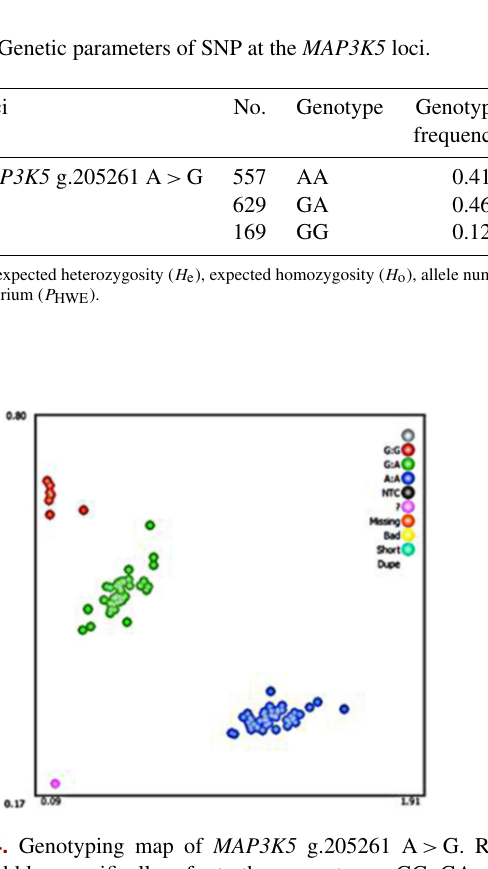
Figure 4. Genotyping map of MAP3K5 g.205261 A > G. Red, green, and blue specifically refer to three genotypes: GG, GA, and AA genotypes. KASPar genotyping failure is represented by pink.